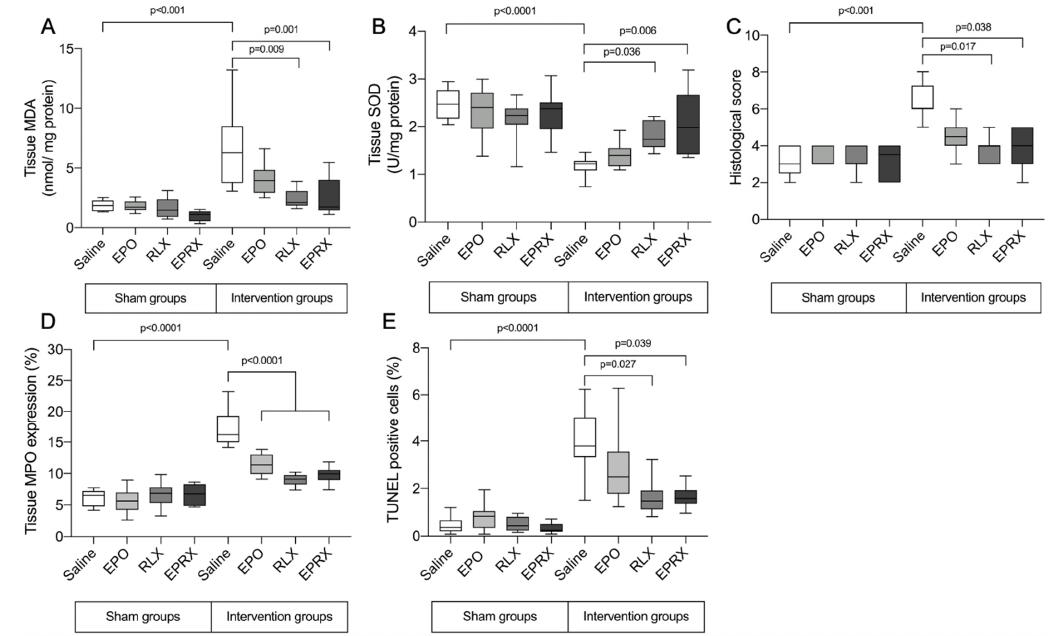
Figure 1. Uterine tissue lesion markers. MDA—malondialdehyde, SOD—superoxide dismutase, MPO—myeloperoxidase, TUNEL—terminal deoxynucleotidyl transferase-mediated dUTP nick-end labeling EPO—erythropoietin, RLX—relaxin, EPRX—erythropoietin and relaxin. Data presented as median (Q1; Q3). ( A , B , C , E ) Kruskal–Wallis test; ( D ) ANOVA test.